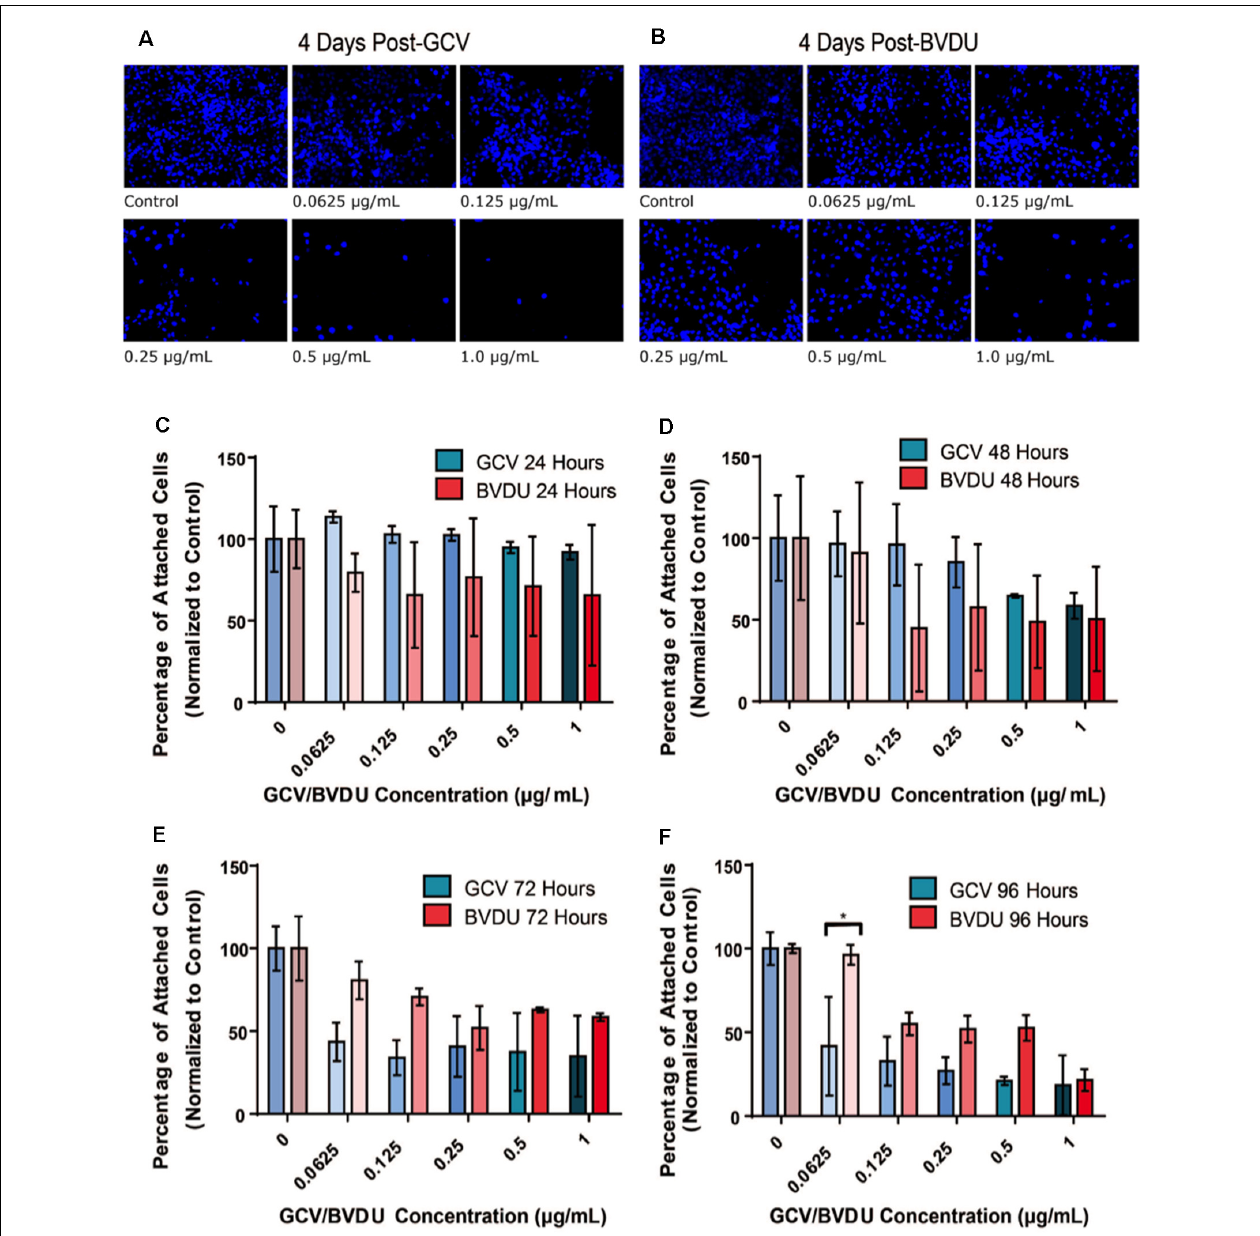
FIGURE 2 | Number of attached HSV-TK NPCs following different durations of GCV treatment. 5.0 × 10 4 HSV-TK NPCs were plated on each well of two separate, 6-well culture plates and subjected to increasing concentrations of BVDU or GCV (0.0625–1 µ g/ml) through media changes after 24 h. Panels (A) and (B) represent the 96-h time point, wherein DAPI + cells are stained and concentrations of GCV and BVDU are indicated in the bottom left of the image. Cell death can be seen in all conditions except for the control. Panels (C–F) display the quantification of cell count data from ablation experiments. Panels show a direct comparison between GCV (turquoise color scheme) and BVDU (red color scheme) at the four collected time points 24 h (C) , 48 h (D) , 72 h (E) , and 96 h (F) . Data were normalized to the control of each timepoint (0 µ g/ml GCV or BVDU), where the control represents 100 percent cell survival and treatment conditions are represented as a percent of the control. To statistically analyze the data, we performed Two-way ANOVAs with Bonferroni post hoc corrections. * P < 0.05. NPC, neural progenitor cell.